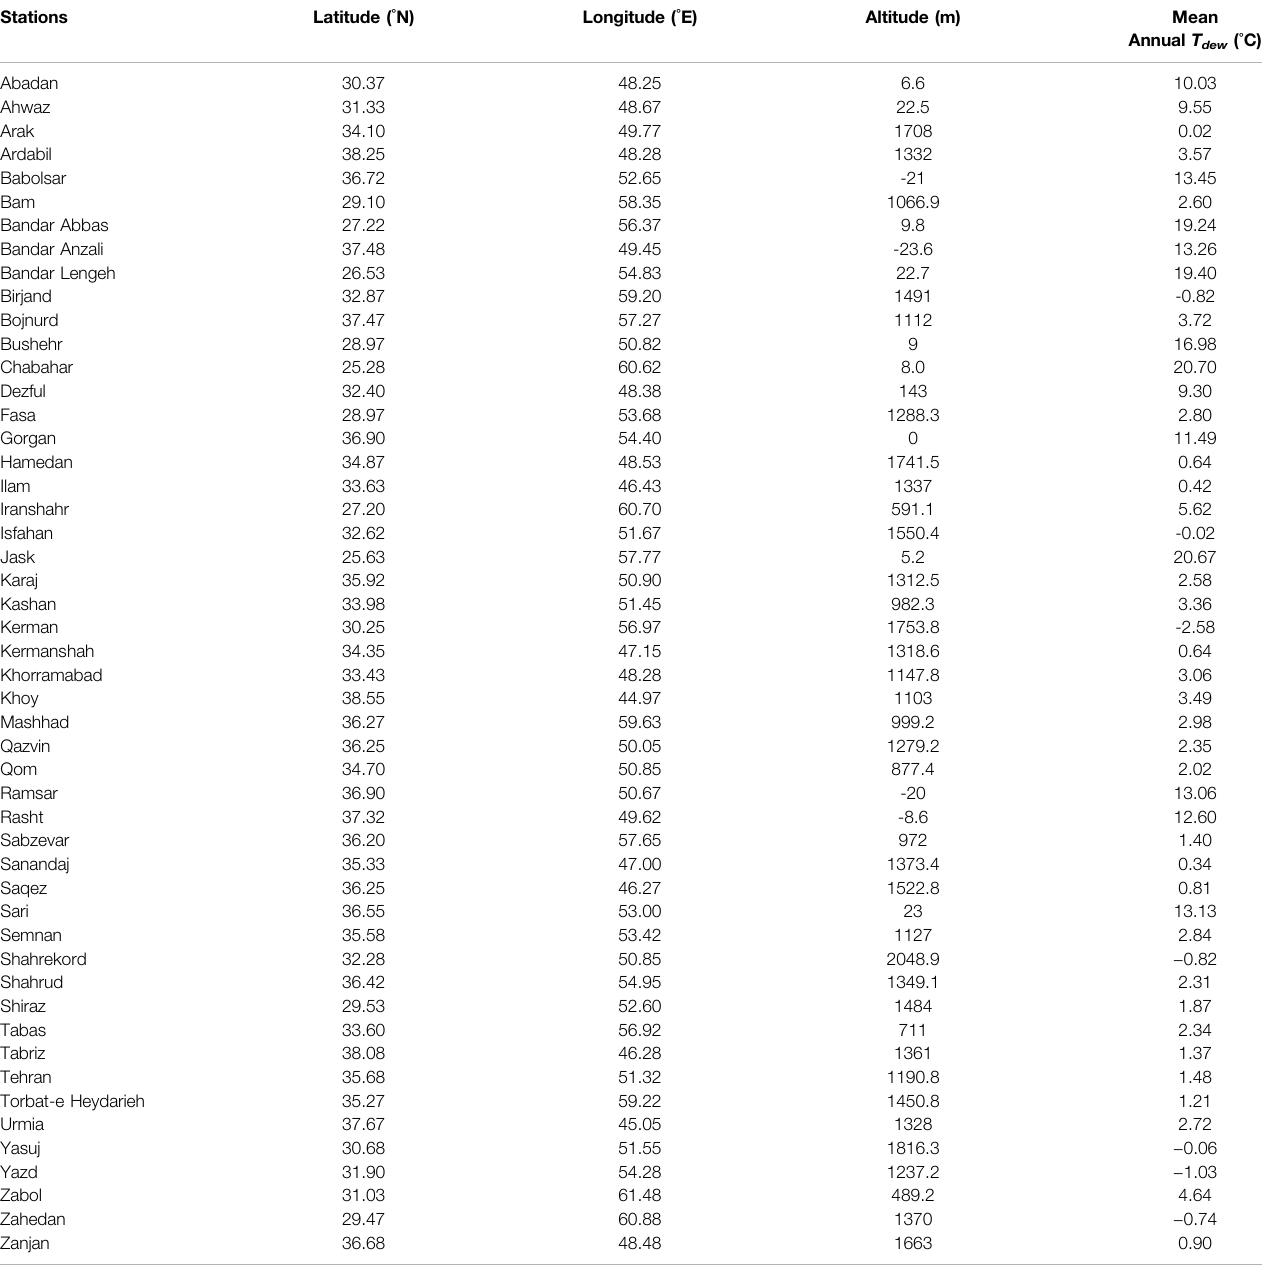
TABLE 1 | Geographical properties of the stations in Iran and long-term mean annual values of T dew . Stations Latitude ( ° N)